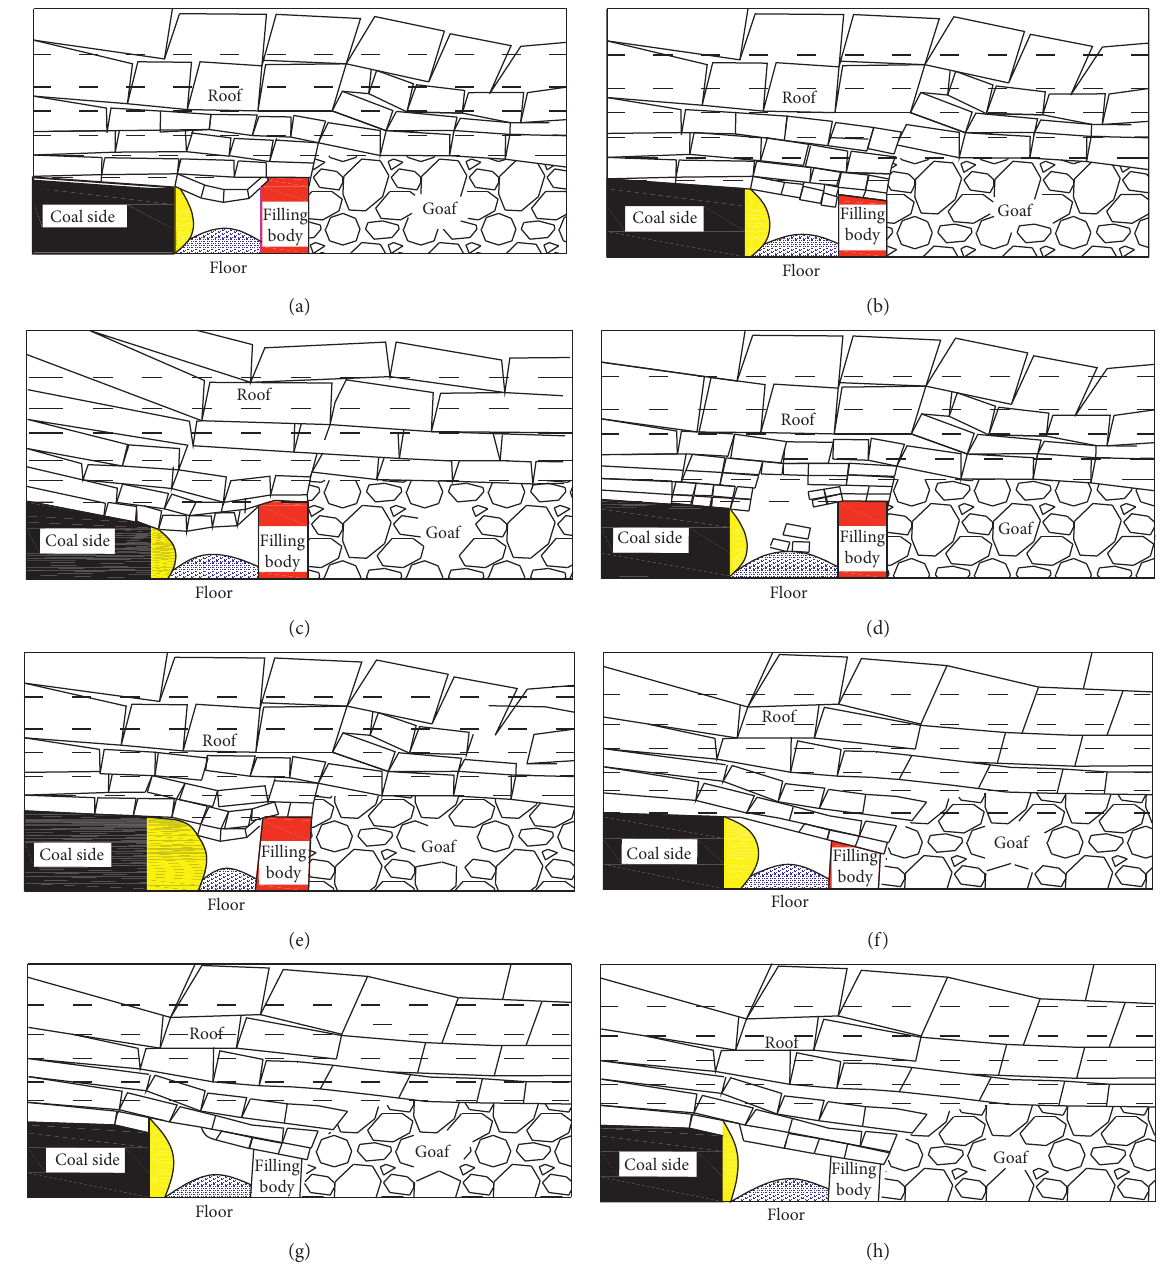
Figure 4: Deformation and failure characteristics of surrounding rock. (a) Roof bending and sinking type, (b) roof cutting along filling body, (c) rib spalling type, (d) roof fall type, (e) filling body rotation type, (f) filling body crushing type, (g) roof step type, and (h) roof cutting along coal